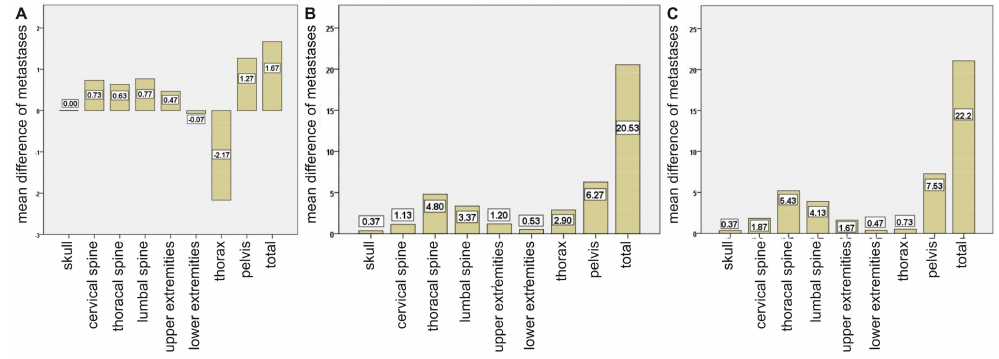
Figure 1. Graph of the average difference of detected lesions based on regions for ( A ) visual analysis of bone scans and semiautomatic analysis (EXINI) of bone scans, ( B ) visual analysis of bone scans and [ 68 Ga]Ga-PSMA-PET/CT, ( C ) semiautomatic analysis of bone scans (EXINI) and [ 68 Ga]Ga-PSMA-PET/CT.